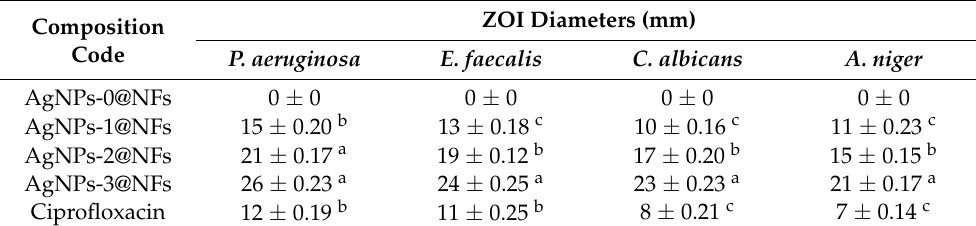
Table 3. Antimicrobial activity and ZOI diameters of AgNPs-0@NFs, AgNPs-1@NFs, AgNPs-2@NFs, and AgNPs-3@NFs against human-associated pathogens.